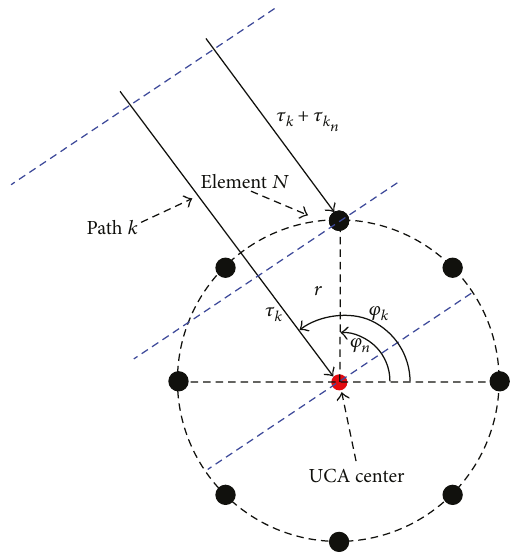
Figure 2: UCA with radius r and N elements for the incoming path k .